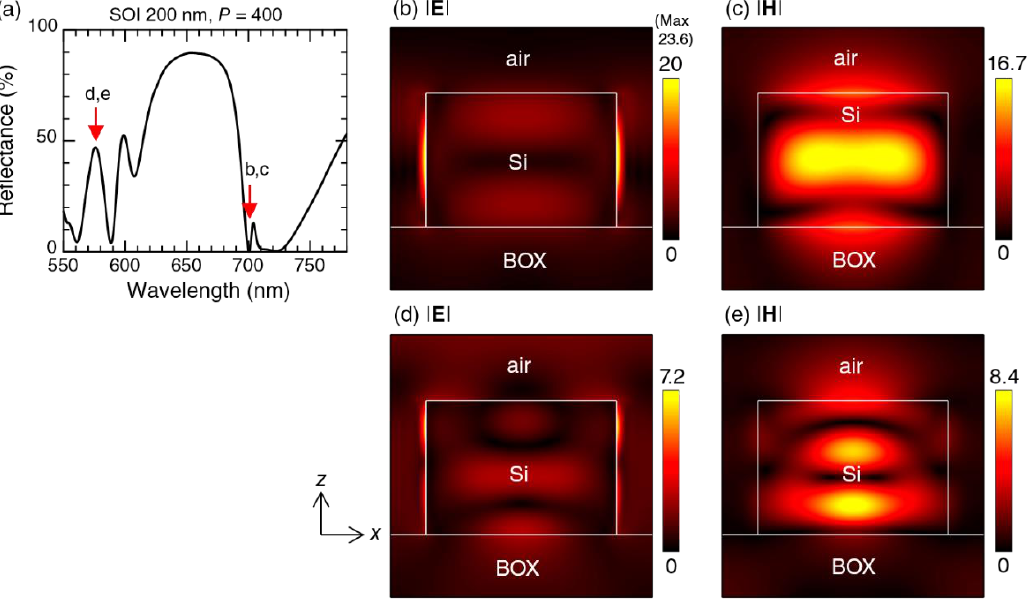
Figure 6. ( a ) Numerically calculated R spectrum for the metasurface of SOI thickness 200 nm and P = 400 nm. Incidence was assumed to be normal. ( b , c ) xz -section views of | E | and | H | distributions, respectively, at the wavelength (701.1 nm), indicated by the arrow with the label b,c in ( a ). ( d , e ) | E | and | H | distributions, respectively, at the wavelength (576.3 nm), indicated by the arrow with the label d,e in ( a ). Incident | E | and | H | were set to 1.0.